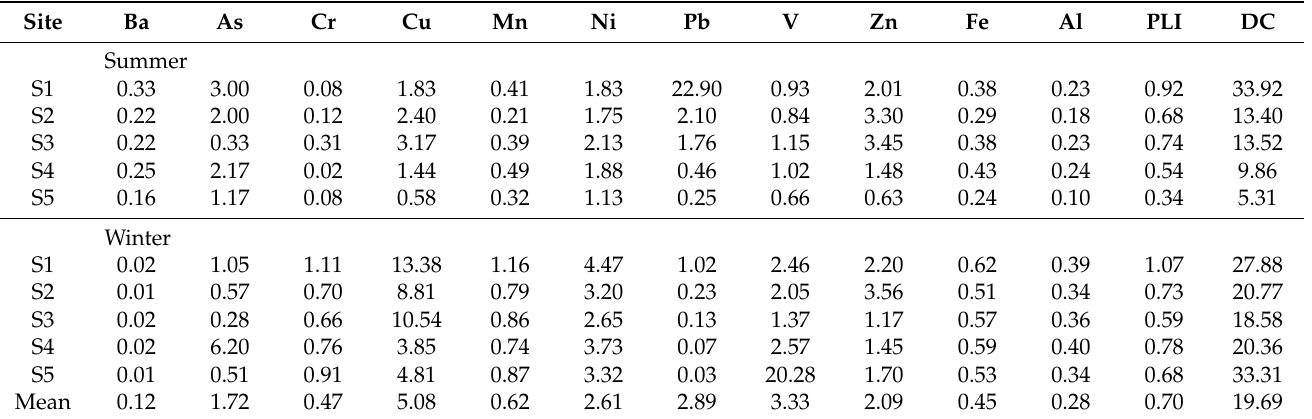
Table 6. The contamination factor (CF), pollution load index (PLI), and degree of contamination (DC) of the investigated metals in the drain sediment samples.